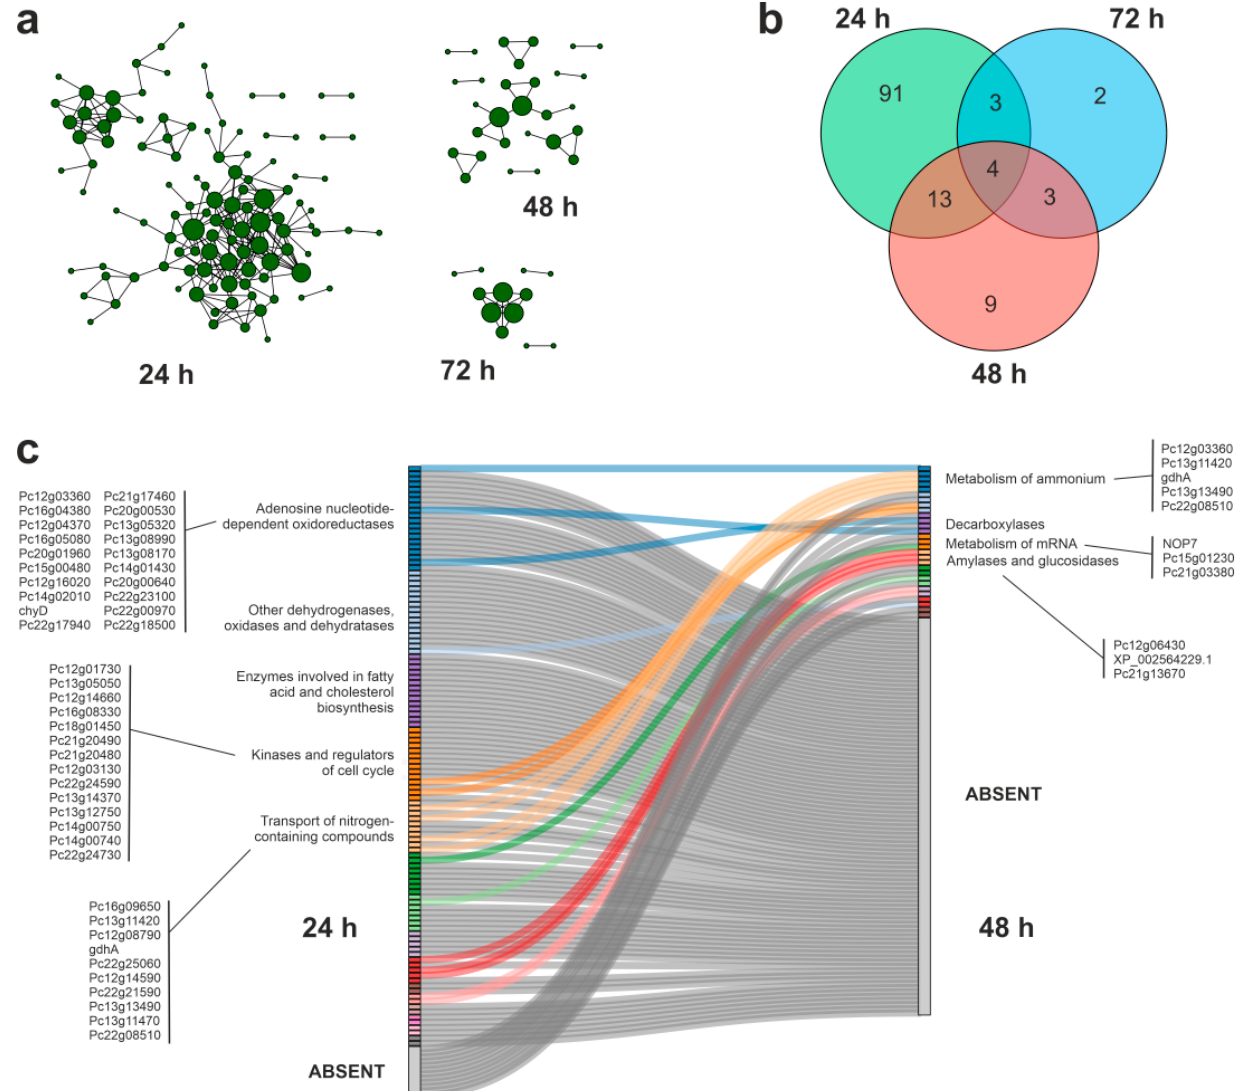
Figure 6. Analysis of the protein–protein interaction networks (PPIs) established among the proteins whose coding genes were downregulated during APAP biodegradation by P. chrysogenum var. halophenolicum and supported by the STRING database [46]. ( a ) schematic representation of the density of interaction nodes among the selected proteins at 24 h, 48 h, and 72 h of culture. ( b ) Venn diagram depicting the number of proteins included in all the PPIs at the analyzed culture times. ( c ) Sankey plot showing the changes in community structure (densely connected groups of nodes) analyzed in the transition between 24 h and 48 h of culture performed by the Netconfer algorithm [47], representing the most relevant families of proteins involved.